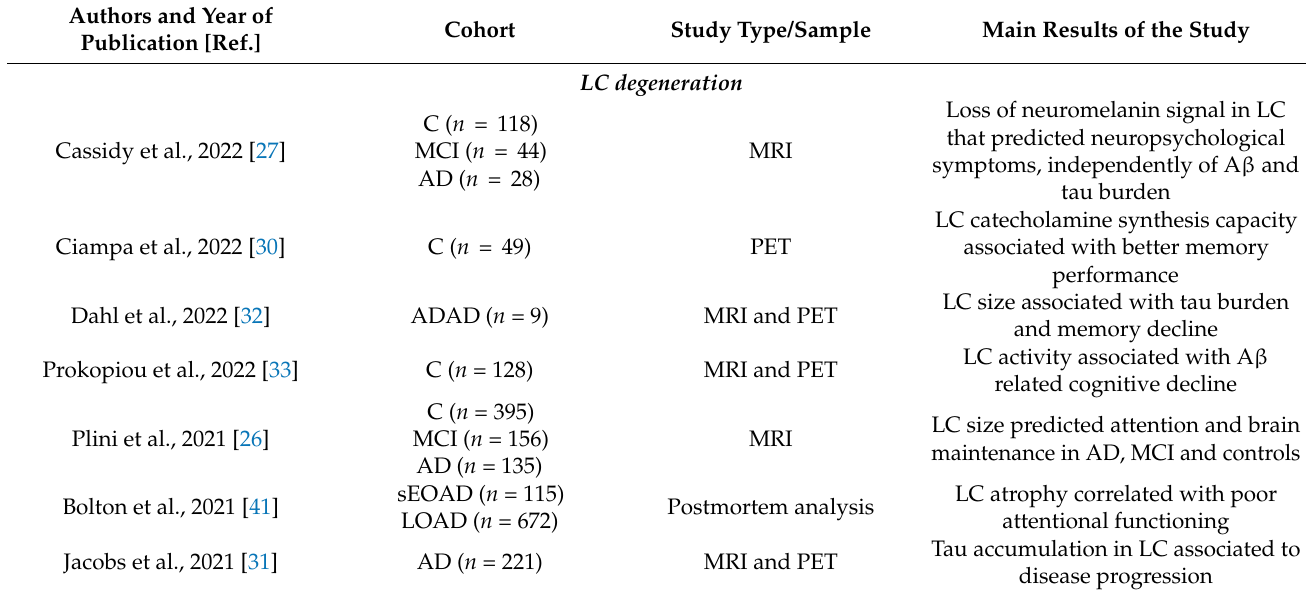
Table 1. Dysfunction of the noradrenergic system in Alzheimer’s